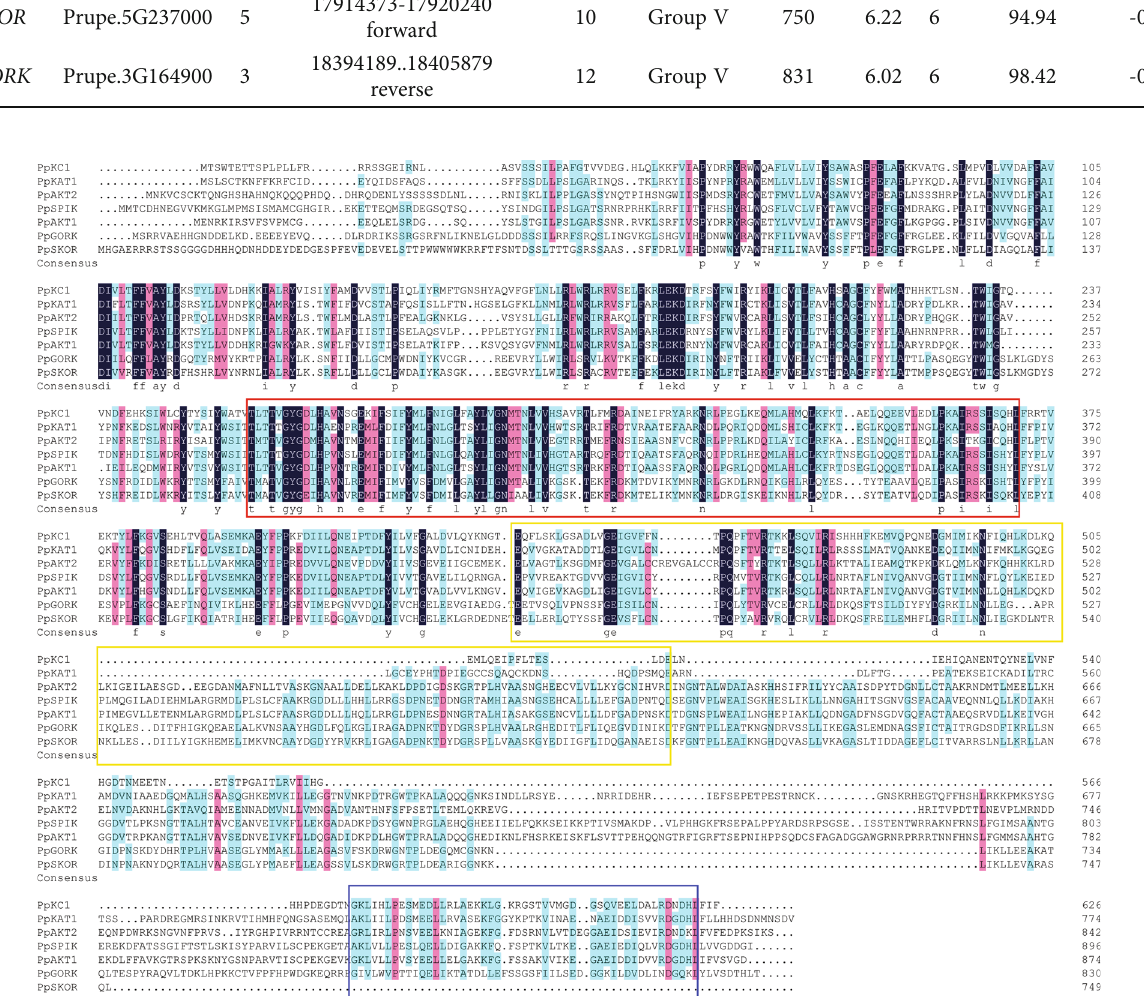
Figure 1: Multiple sequence analysis of the peach shaker K + channel